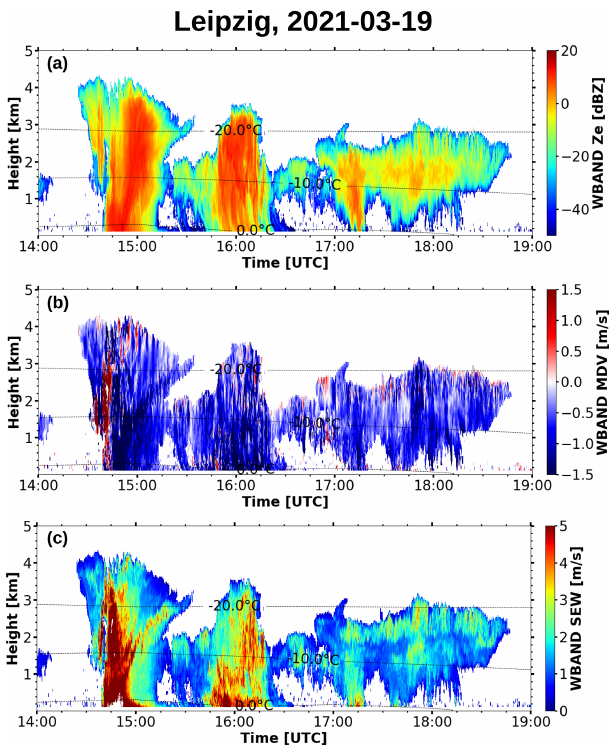
Figure 8. Radar moments measured by LIMRAD94 during the case on 19 March 2021. (a) Equivalent radar reflectivity in dBZ. (b) Mean Doppler velocity. (c) Spectrum edge width